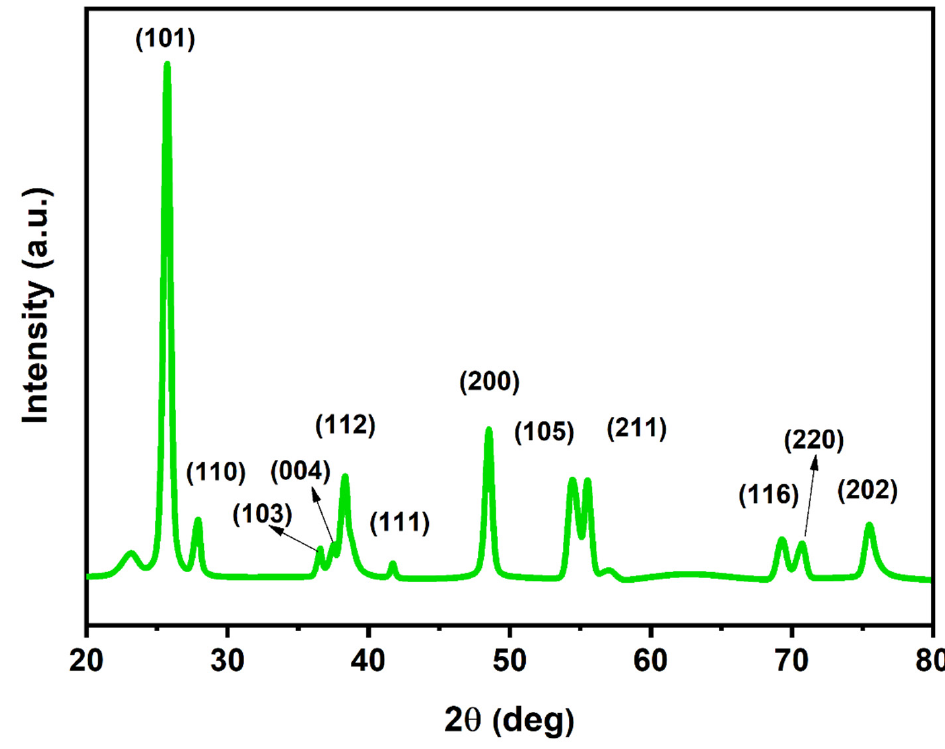
Figure 2. X-ray diffraction pattern shows sharps peaks for the crystalline nature and different phases of the synthesized TiO 2 of the synthesized TiO 2 .